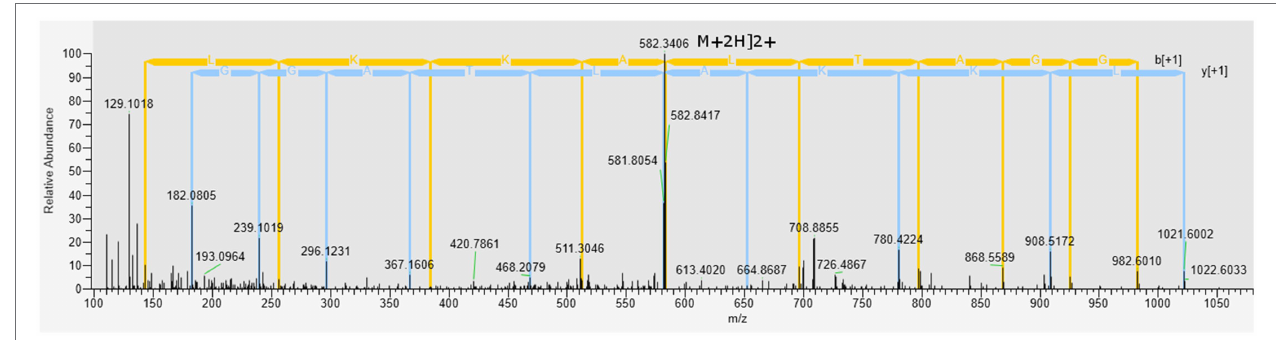
FIGURE 4 | Mass spectrum (MS/MS) of the antimicrobial peptide (ACAP-I), from C. gariepinus . Representative MS 2 data were obtained from a +2 parent ion with m/z 582.340 by HCD fragmentation and Orbitrap detection at 30.000 resolution. The y - and b - series of ions allows identification of the peptide AALKKALTAGGY from protein with accession number